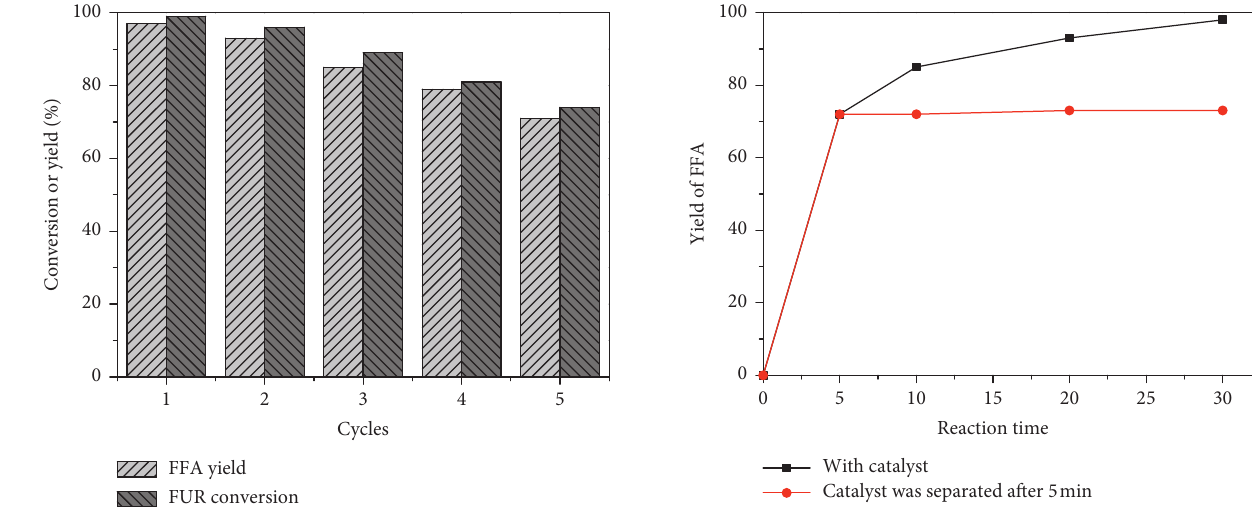
Figure 9: The FFA yield with or without the participation of 5wt.% 2. Reaction KF/ZrO 2. Reaction conditions: 0.5mmol FUR, 25mg 5wt.%